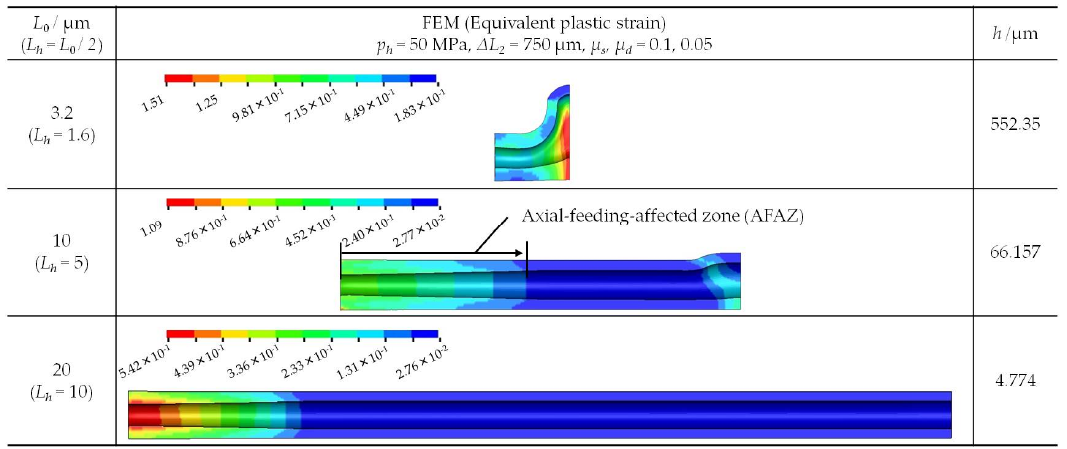
Figure 18. Effect of the initial tube length on the deformation and equivalent plastic strain of a micro ‐ T ‐ shape tube.